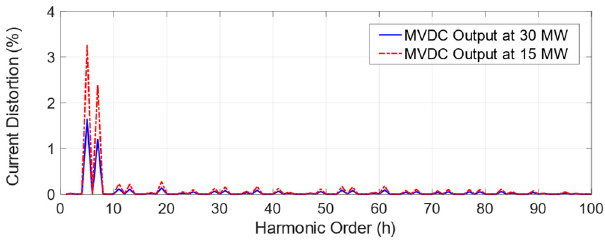
Figure 30. Total output current spectra of the MVDC system for the two operating conditions.